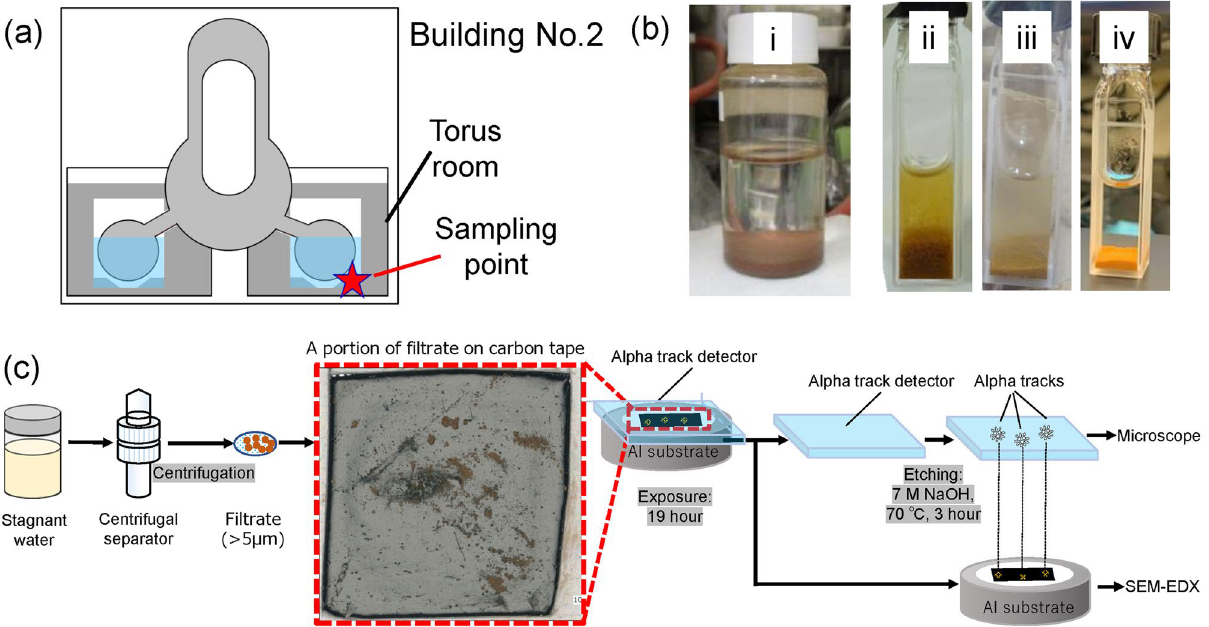
Figure 1. ( a ) Schematic of sampling location. ( b ) Photographs of stagnant water: (i) original solution and (ii) 0 min, (iii) 20 min, and (iv) 2 h after separation from the original solution. ( c ) Schematic of sample preparation procedure for alpha track detection and SEM–EDX